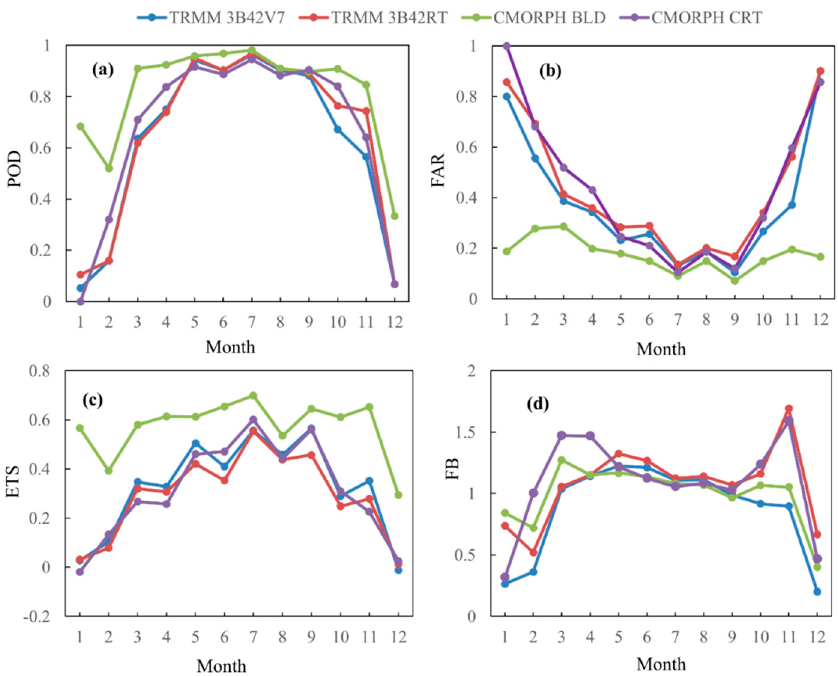
Figure 9. Monthly statistics of ( a ) POD, ( b ) FAR, ( c ) ETS and ( d ) FB of different daily satellite products against CGDPA at the threshold of 1 mm/day during 2006–2013.